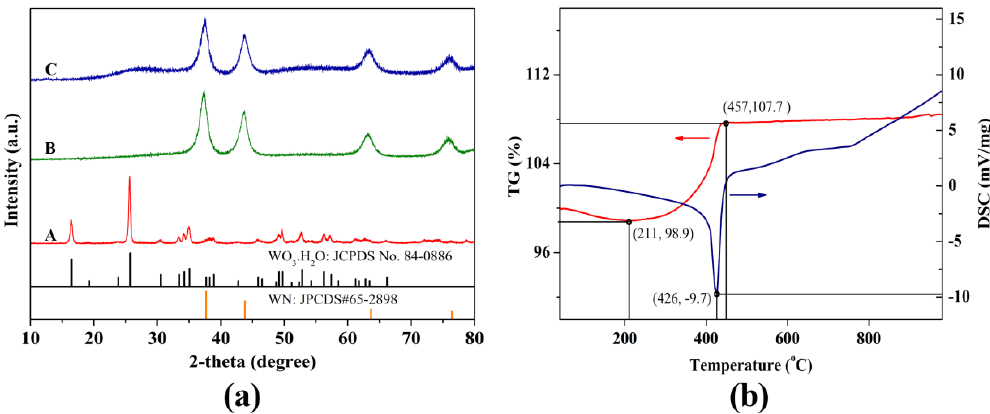
Figure 1. ( a ) Powder X-ray diffraction (XRD) patterns of tungsten oxide hydrate (WO 3 ·H 2 O) A, tungsten nitride (WN) B and hybrid tungsten nitride and oxide (WN/WO 3 ) composites C; ( b ) differential scanning calorimetry-thermal gravimetric analysis (DSC-TGA) curves of WN/WO 3 composites.